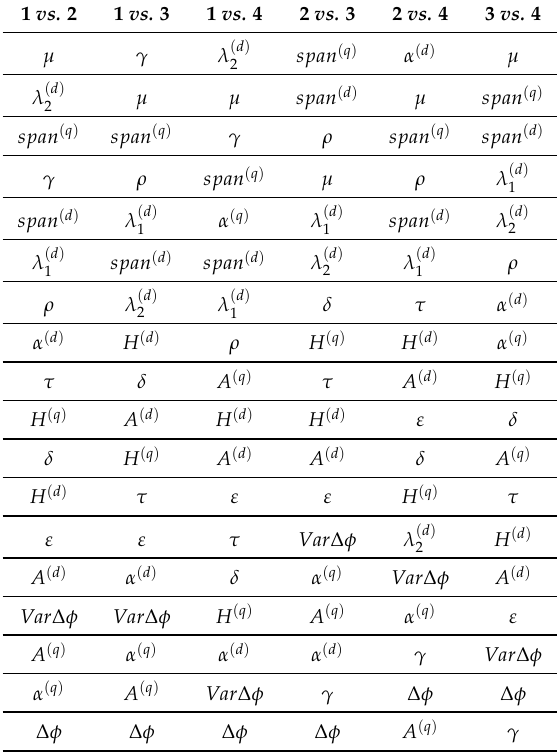
Table 4. TS-X, 2014/04/23: Two-class-relevance in descending order for different pairs of classes. Class indices are: 1: OW, 2: YI, 3: SFYI, 4: RFYMYI. 1 vs. 2 1 vs.